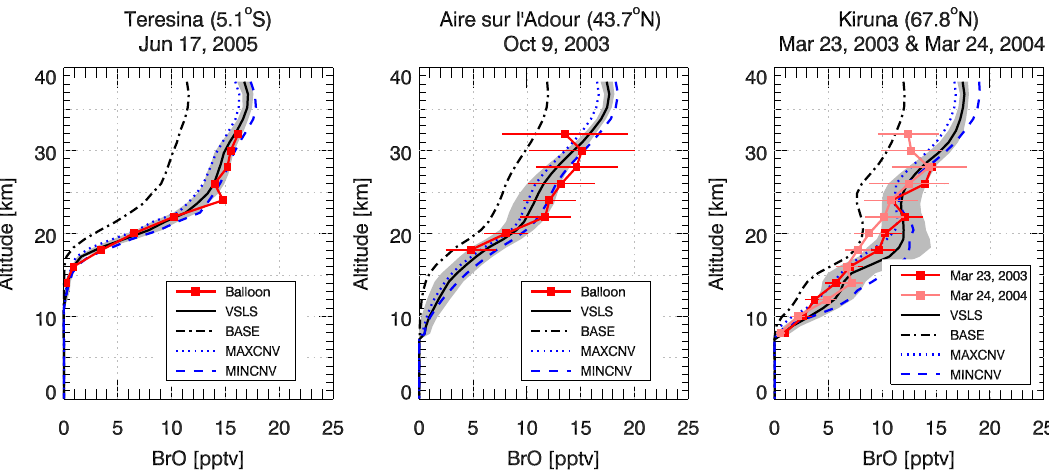
Figure 2. Comparison of simulated BrO from the GEOSCCM run R VSLS (black solid line with one sigma variance in gray shading) with balloon measurements (red line with one sigma uncertainty in horizontal bars) from the LPMA/DOAS spectrometers in the stratosphere. The black dash-dotted line shows simulated BrO from the run without VSLS ( R BASE ). Simulated BrO from the two convective sensitivity simulations is also shown (dotted line for maximum convection condition and dashed line for minimum convection condition). The model is sampled at the same month and latitude as the balloon measurements but only daytime profiles from all available longitude grid points are collected to calculate the one sigma variance of simulated